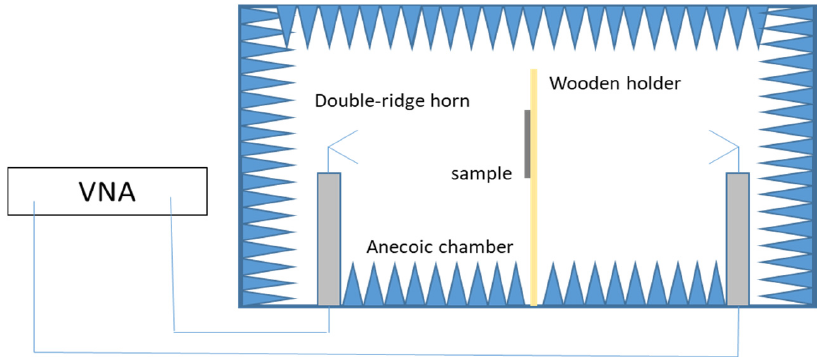
Figure 3. Sketch of the measurement system.